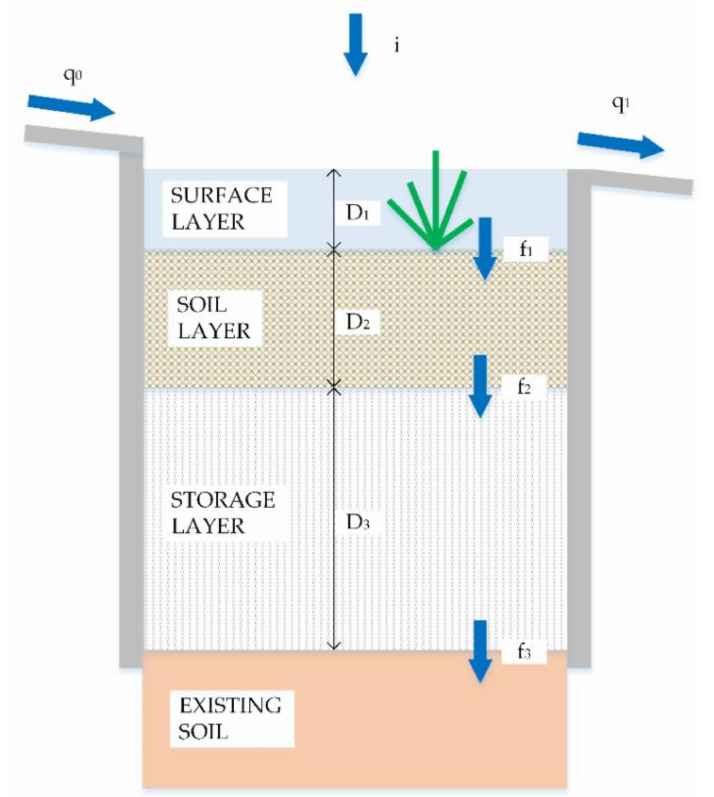
Figure 2. A conceptual model of a typical bio-retention cell (adapted from [15]). Variables and constants included in the SCM equations are described in Tables 4 and